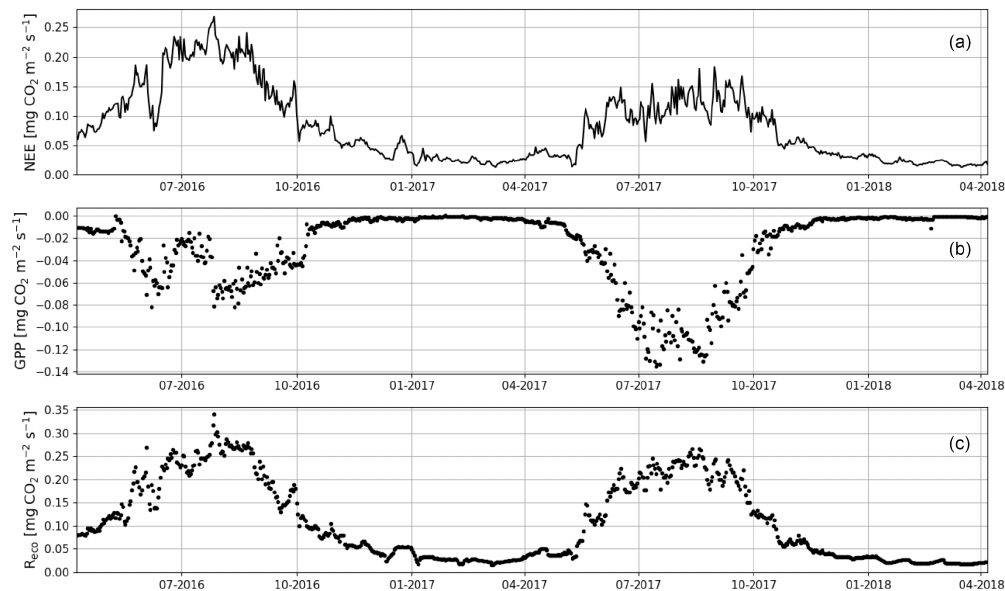
Figure 4. The gap-filled time series of daily mean net ecosystem exchange (NEE, a ) and the corresponding modelled gross primary produc- tion (GPP, b ) and ecosystem respiration ( R eco , c ) based on Eqs. (A2) and (A3), respectively.